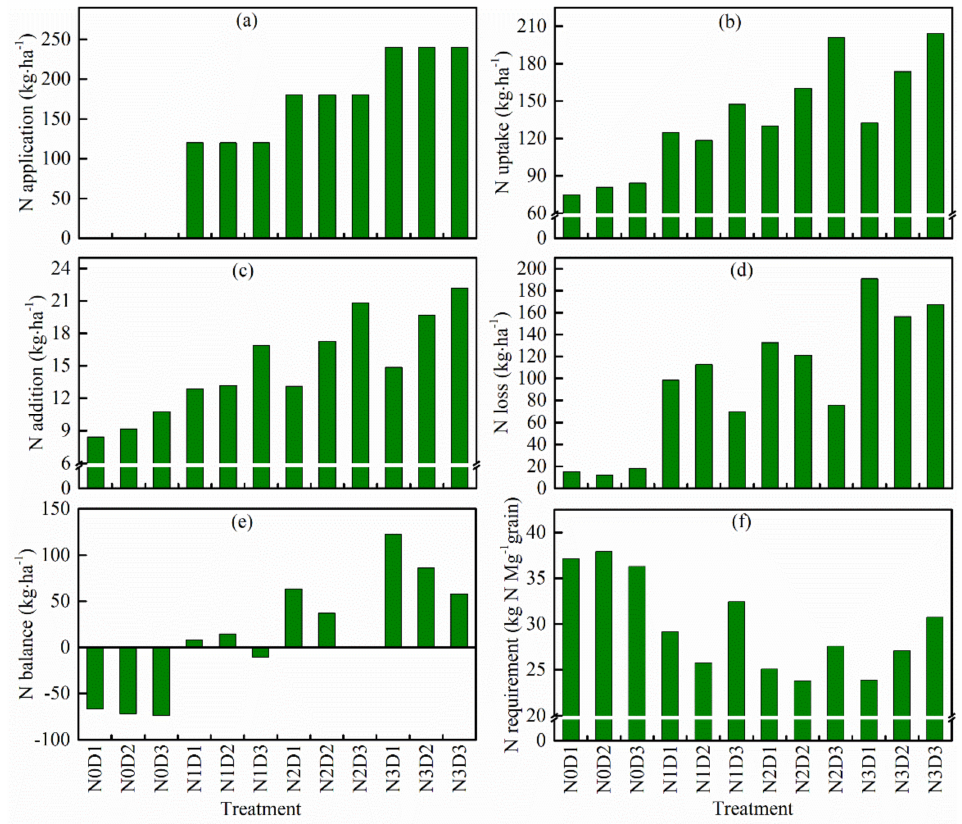
Figure 8. Soil N balance and N requirement under different N rates and plating densities in the perennial rice cropping system. ( a ) N application. ( b ) N uptake. ( c ) N addition. ( d ) N loss. ( e ) N balance. ( f ) N